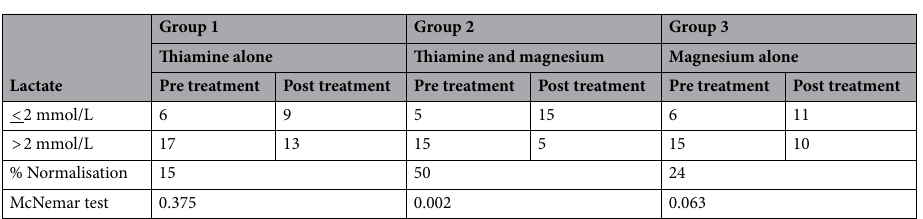
Table 5. Pre- and post-treatment plasma lactate in the context of low circulating serum